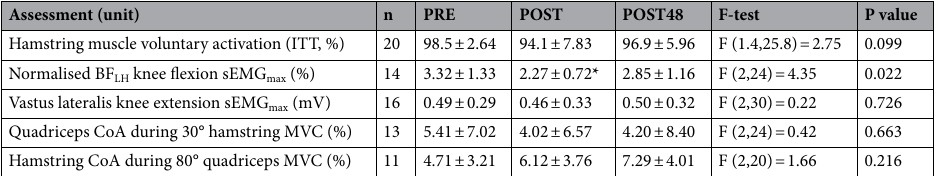
Table 1. Effect of the repeated maximal sprint intervention on measures of muscle activation. Data are presented as mean ± SD. One-way ANOVA, F- and P-values are reported. ITT interpolated twitch technique, BF LH biceps femoris long head, CoA co-activation, sEMG surface electromyography. *Different to PRE (P < 0.05).